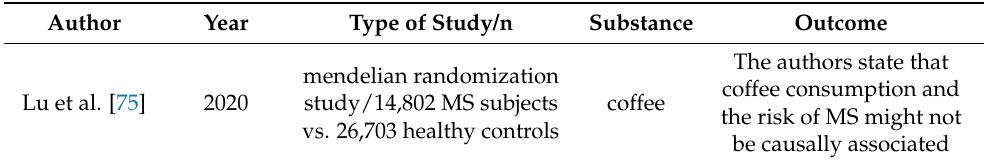
Table 5. Summary of recent clinical studies investigating the relationship between methylxanthines and multiple sclerosis (MS). n : sample